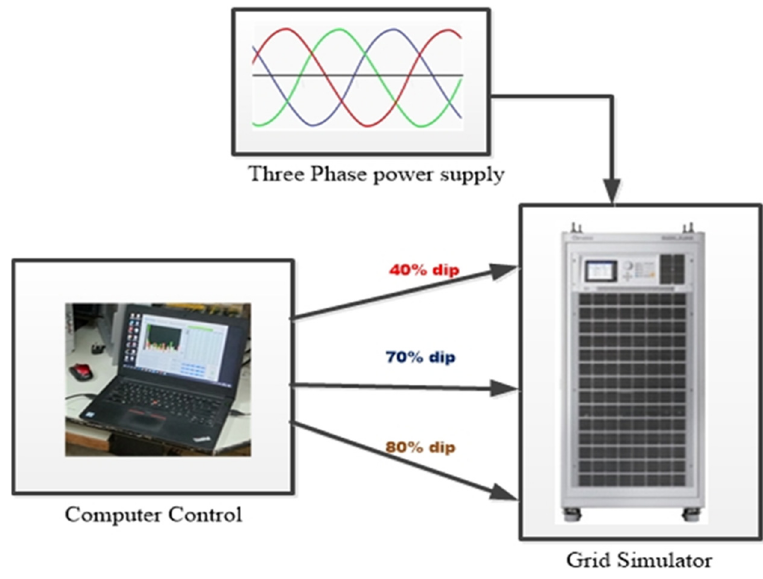
Figure 4. Voltage sag conditions in grid.